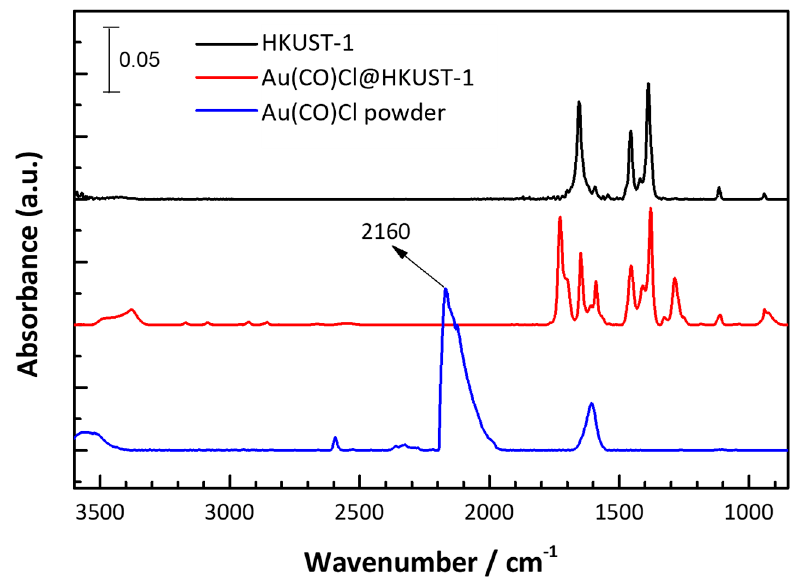
Figure 5. IR spectrum at 20 °C for empty HKUST-1 (black), for Au(CO)Cl@HKUST-1 (red) and Au(CO)Cl powder (blue). Au(CO)Cl powder